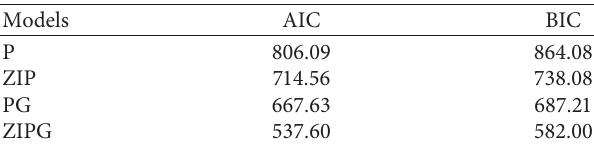
Table 1: Maternal mortality data. AIC and BIC comparison for all models